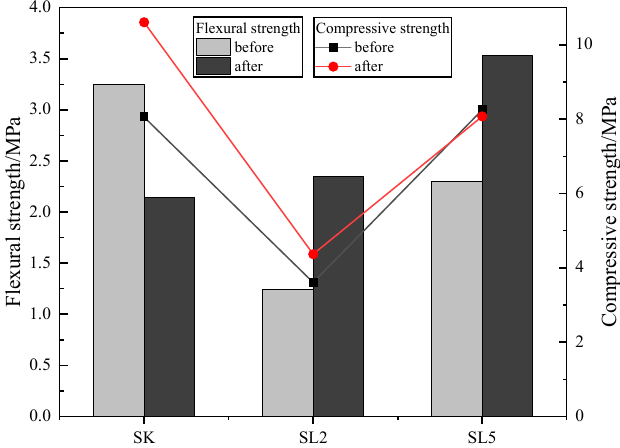
Figure 11. Strength comparison in soundness experiment.